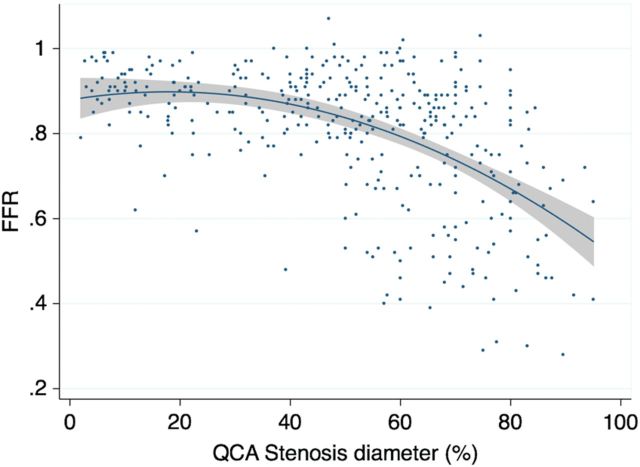
 Distribution of percentage of diameter stenosis and fractional flow reserve in stenoses. Despite a significant inverse correlation between percentage of diameter stenosis and fractional flow reserve, a substantial variability between the two parameters is noted ( R2 = 0.23, P < 0.01). The curve is fitted by second-order polynomial.